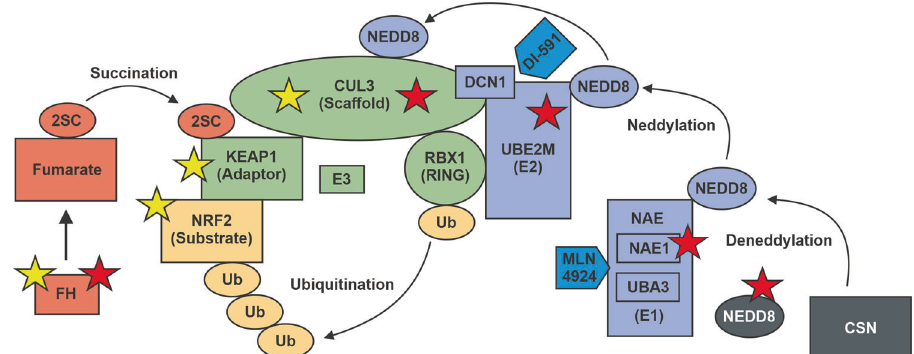
Fig. 4 Schematic illustration of mechanisms leading to oncogenic NRF2 activation. NRF2 is, under basal conditions, ubiquitinated by the KEAP1/CUL3/RBX1 E3-ubiquitin ligase complex. Neddylation is required for the activation of cullin-RING ubiquitin ligases (CRL). The COP9 signalosome (CSN) is responsible for deneddylation of CRL. KEAP1 plays a central role in regulating the activity of NRF2. In cancers, the interaction between the E3 subunits can be disrupted by speci fi c mutations in NFE2L2 (encoding NRF2) or by biallelic loss of KEAP1 or CUL3 (yellow stars). The interaction between NRF2 and KEAP1 can also be disrupted by protein succination of critical cysteine residues within KEAP1 as a result of fumarate accumulation. Oncogenic activation of the NRF2 pathway can be seen in uterine leiomyomas that harbor biallelic loss of FH or biallelic loss of key members involved in the neddylation pathway (red stars). Finally, inhibition of neddylation by MLN4924 or DI-591 results in activation of